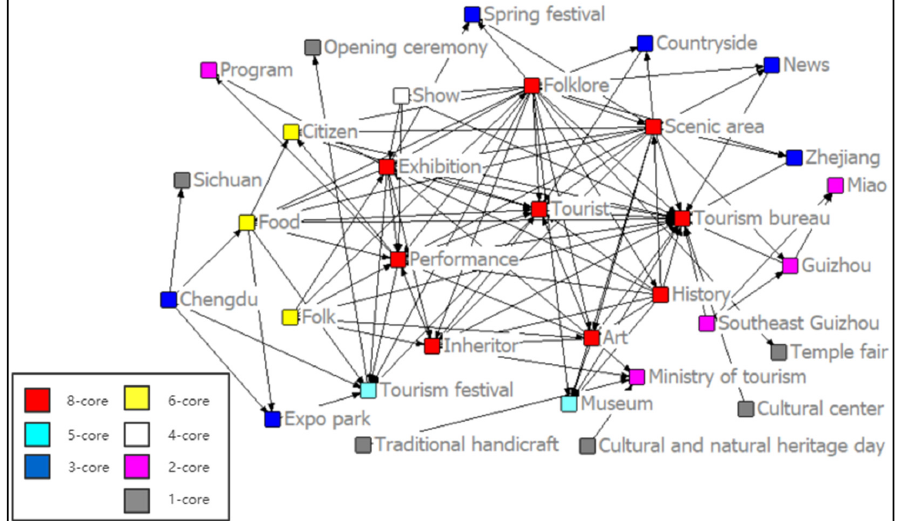
Figure 4. Semantic network results of ICH tourism cognition based on K-core